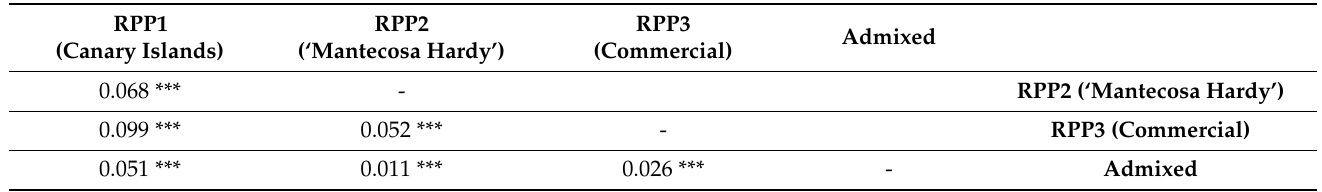
Table 7. Differentiation between pairs of populations (Fst) in diploids for K = 3, 18 SSRs.